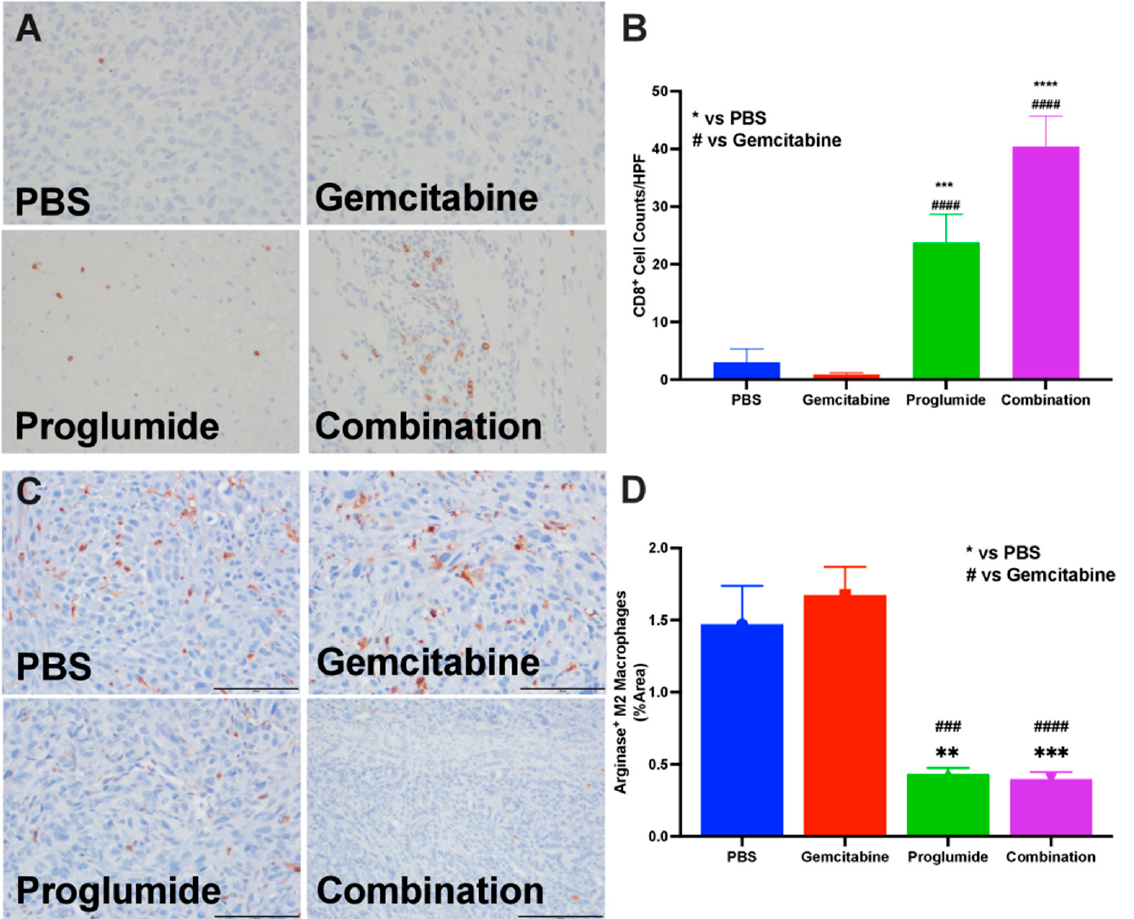
Figure 3. Proglumide therapy alters the tumor immune cell signature. ( A ) A representative tumor section from each treatment group showing immunoreactivity for CD8 + tumor-infiltrating lymphocytes from mT3-2D tumors. The 5 µ m tissue sections were imaged with a 10× objective, 200 µ m. ( B ) Analysis of the number of tumor-infiltrating CD8 + T-lymphocytes is shown. Columns represent means per group ± SEM ( # compared to gemcitabine, * compared to PBS controls; *** and ### p < 0.001; **** and #### p < 0.0001). ( C ) Representative images from tumors of each treatment group of the mT3-2D tumors shows immunoreactivity for arginase indicating immune suppression within the TME in each tumor section. ( D ) Analysis of the percentage of arginase positive cells per area examined on each tumor section. Columns represent means per group ± SEM ( # compared to gemcitabine, * compared to PBS controls; ** p < 0.005; *** and ### p < 0.001; #### p < 0.0001).